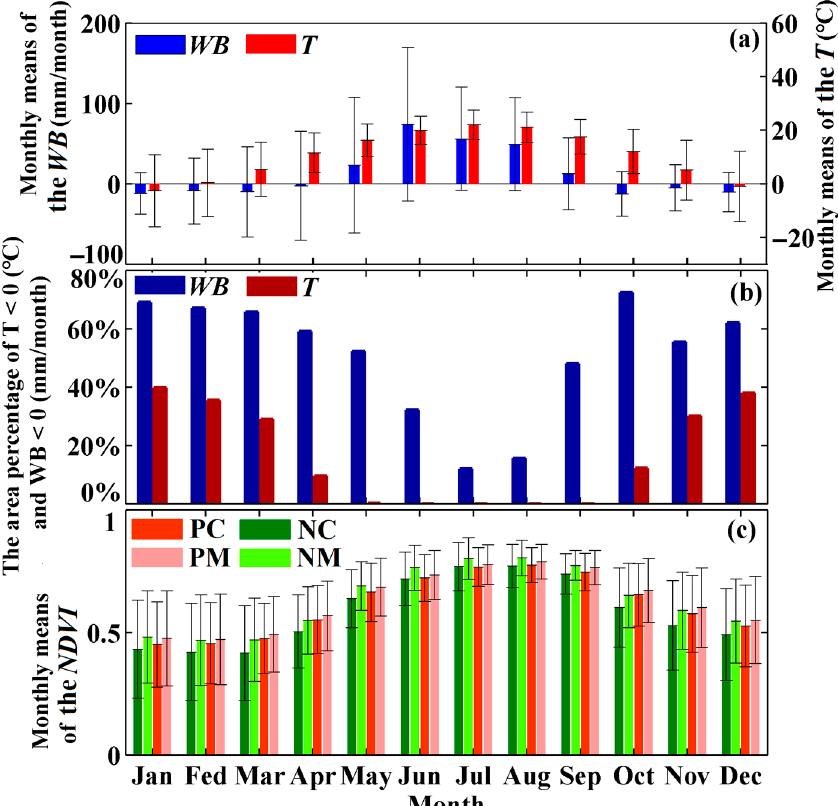
Figure 2. The seasonal changes in ( a ) monthly means of the temperature ( T ) and water balance ( WB ), ( b ) area percentage of T < 0 (°C) and WB < 0 (mm/month), and ( c ) monthly means of the NDVI of forests during 2001–2015. The PC, PM, NC, and NM represent planted coniferous, planted mixed, natural coniferous, and natural mixed forests, respectively. The NDVI data were obtained from the Moderate Resolution Imaging Spectroradiometer ( MODIS ), and the temperature and water balance data were obtained from Climatic Research Unit (CRU, University of East Anglia, UK), for which detailed information can be found in Sections 2.2.1 and 2.2.4, respectively. Only the regions with the minimum NDVI greater than 0 during January-September for the entire study period were considered in the results, which occupied 90.93% of the total forest cover. Detailed information on this can be found in Section 2.2.2. The whiskers of the bar represent the standard deviation of related data.